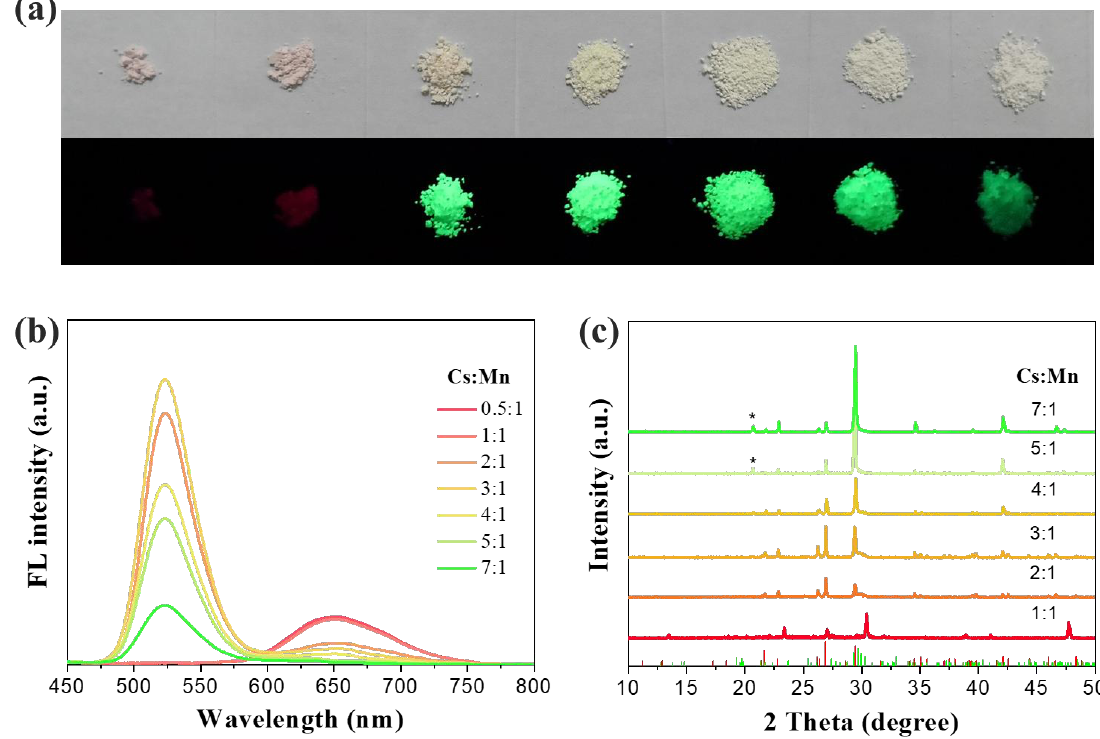
Figure 4. Photographs ( a ) and PL emission spectra ( b ) of the as-prepared Cs x MnBr x+2 samples with different Cs/Mn ratios; ( c ) the XRD patterns of Cs x MnBr x+2 samples with different Cs/Mn ratios.